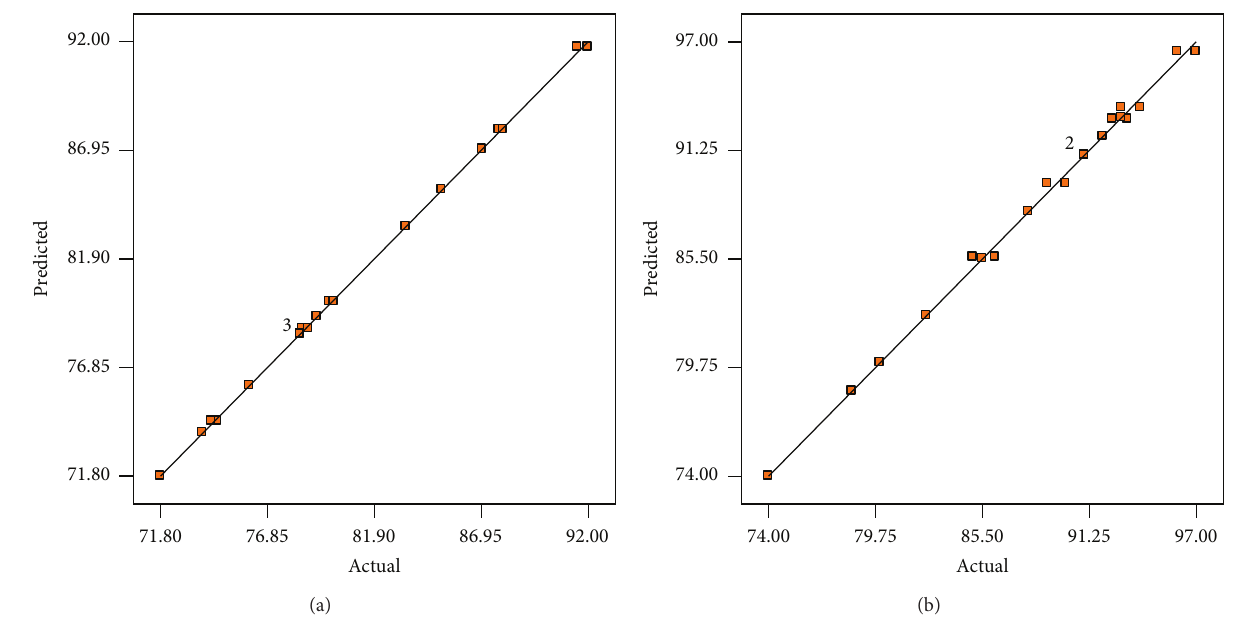
Figure 8: Actual versus predicted biodiesel yield using mollusks (a) and crabs (b) shells-CaO.